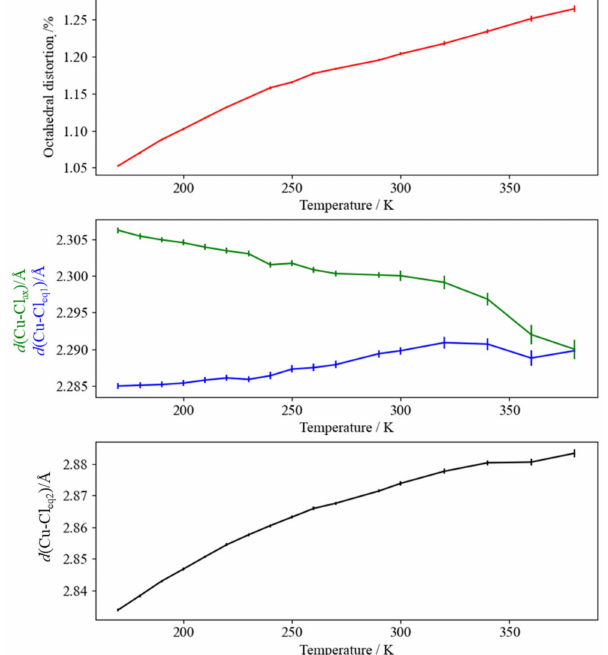
Figure 5. Parameters of octahedral geometry in aacn 2 CuCl 4 as a function of temperature ( ± 1 σ error bars included). Octahedral distortion monotonically increases through the temperature range. The square planar geometry of CuCl 4 unit becomes more symmetrical at high temperatures, but the elongation perpendicular to the plane becomes more pronounced. The symmetrization of the square planar anion could be the underlying mechanism behind observed